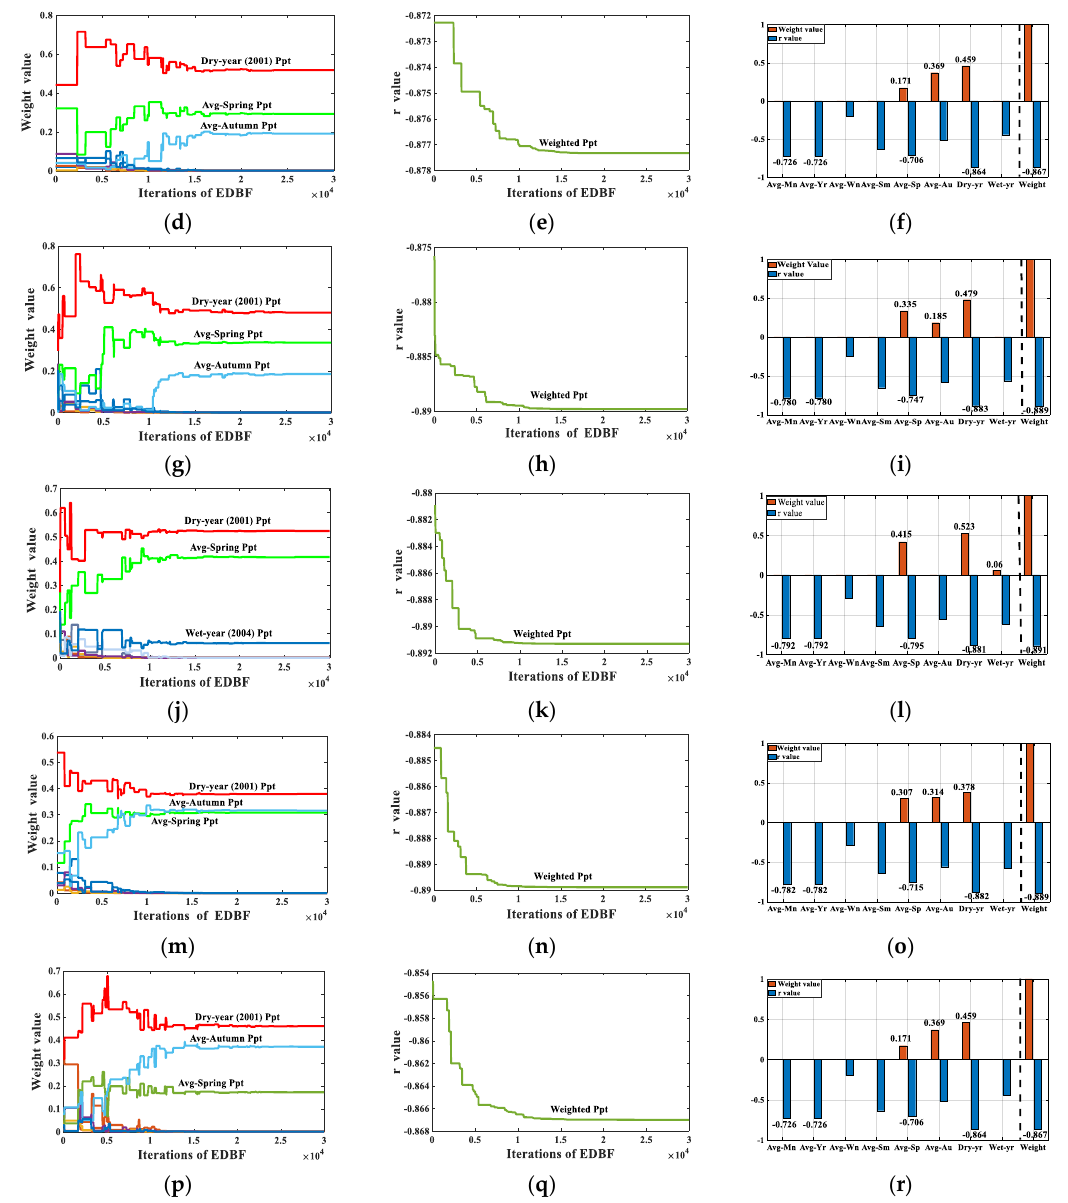
Figure 4. Execution of EDBF algorithm at different low-resolution scales, ( a , d , g , j , m , p ) iteratively estimated weighted values, ( b , e , h , k , n , q ) iteratively estimated r values, and ( c , f , i , l , o , r ) the comparison between assigned weights and estimated r values at 0.25°, 0.50°, 0.75°, 1.0°, 1.25°, 1.50° resolutions, respectively.